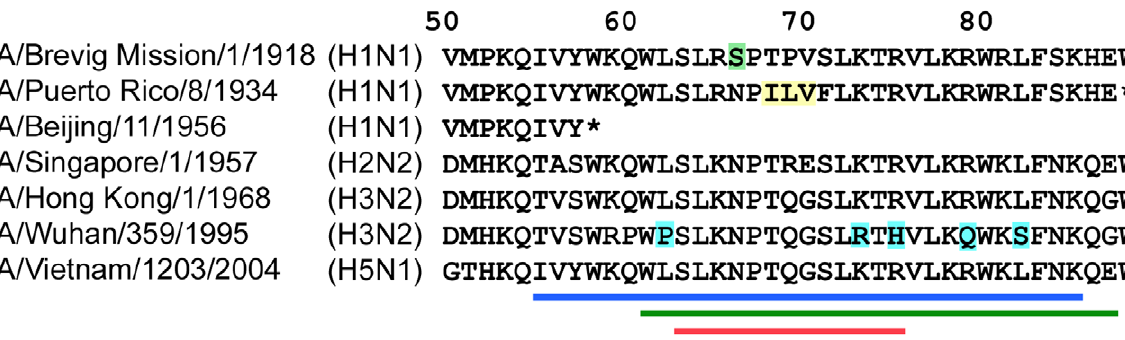
Figure 1. PB1-F2 sequences of viruses used in this study. A comparison of the predicted amino acid sequences of the C-terminal regions of PB1-F2 proteins of several epidemiologically important strains is presented. Colored lines at the bottom of the Figure represent the amino acid composition of the predicted helical region (blue), the 27-mer peptides used in this study (green), and the predicted mitochondrial targeting sequence (red). Blue shading highlights differences in predicted amino acid sequence between the seasonal (1995) and pandemic (1968) H3N2 strains. Yellow shading indicates amino acids predicted to be involved in the cell death phenotype of PR8 (see discussion). Green shading highlights the N66S mutation, a predicted virulence determinant for the 1918 pandemic strain